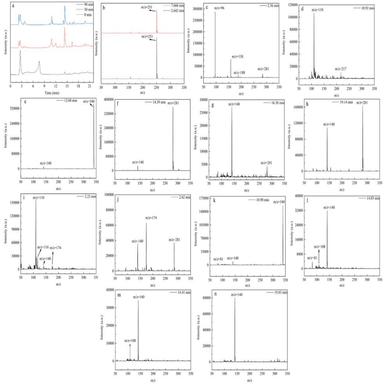
LC-MS images (a); Mass spectrums of SD (b); Mass spectra of the intermediates after degradation for 30 min (c–h), and 90 min (h–n).